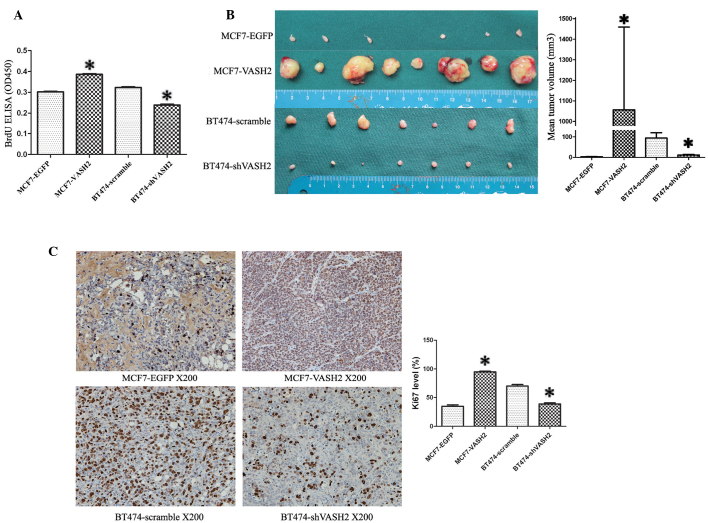
VASH2 induced proliferation in human breast cancer cells in vitro and in vivo. (A) In vitro effects of VASH2 on cell proliferation measured by BrdU incorporation, which was measured using ELISA. Absorbance was read at 450 nm (*P<0.05, n=8). (B) Xenograft tumors from mice injected subcutaneously with MCF7-EGFP, MCF7-VASH2, BT474-scramble or BT474-shVASH2 cells. The data are presented as the mean ± standard error of tumor volume of each group. MCF7-EGFP (2.8±1.1 mm3) vs. MCF7-VASH2 (1057.0±402.8 mm3), *P<0.05, n=8; BT474-scramble (94.4±25.5 mm3) vs. BT474-shVASH2 (11.3±3.3 mm3), #P<0.05, n=7. (C) Immunohistochemistry of Ki67 in xenograft tumors. The data presented are the average Ki67 level ± standard error (%) of tumors for each group. MCF7-EGFP (34.8±2.5) vs. MCF7-VASH2 (95.0±1.2), *P<0.05; BT474-scramble (69.8±2.8) vs. BT474-shVASH2 (33.8±1.8), #P<0.05. BrdU, bromodeoxyuridine; OD, optical density; EGFP, enhanced green fluorescent protein; VASH2, vasohibin-2.